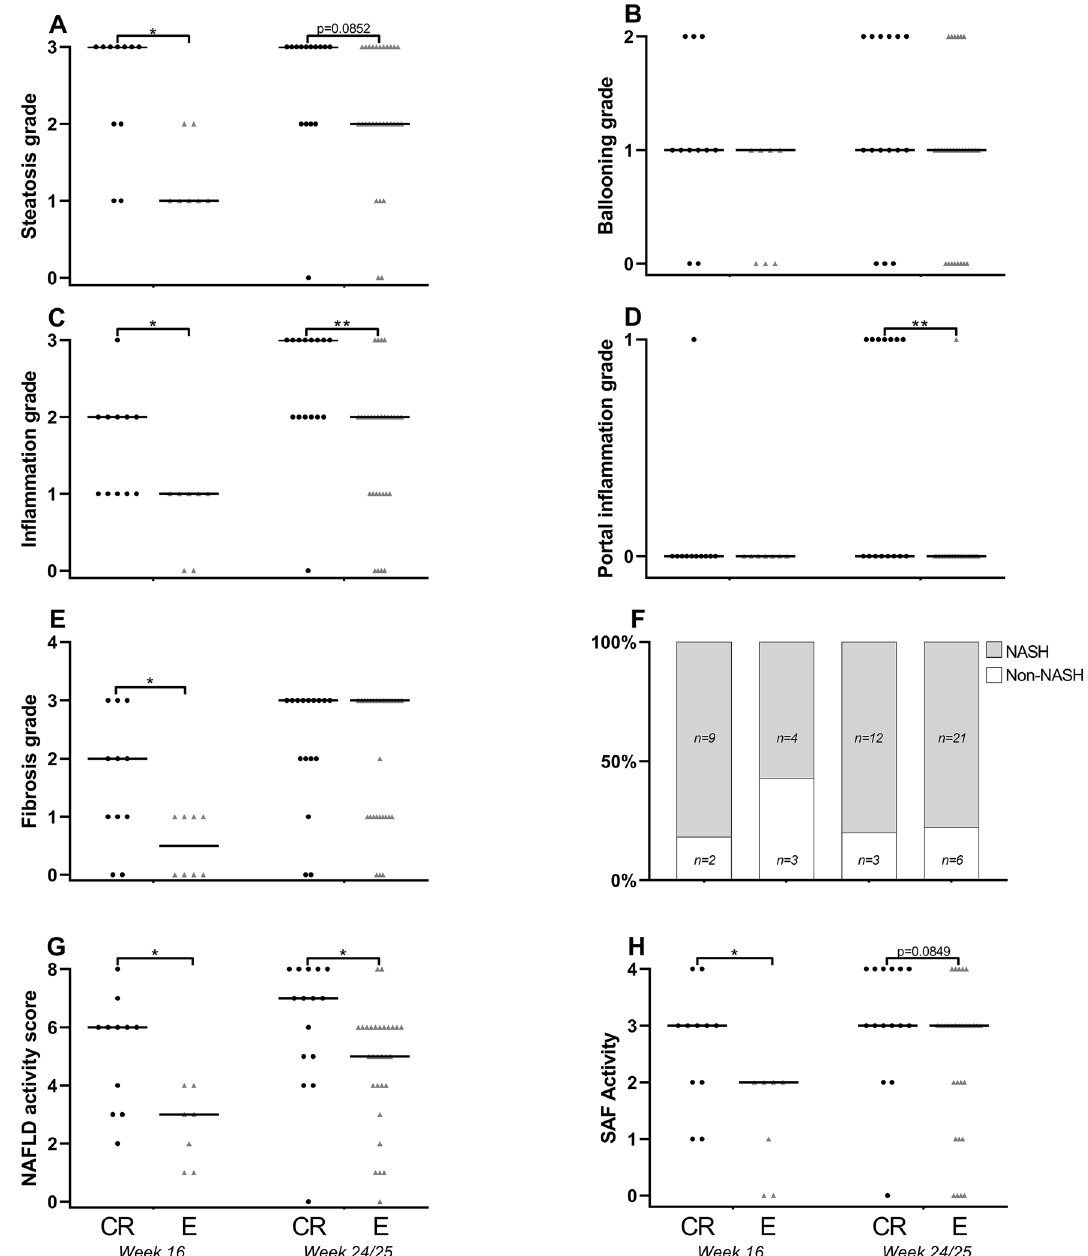
Figure 2. Liver histology and disease severity. Guinea pigs from Charles River displayed an overall more severe NASH phenotype compared with animals from Envigo. ( A ) Steatosis was higher in guinea pigs from Charles River at week 16, ( B ) while hepatocyte ballooning did not differ between animals from the two breeders. ( C ) Lobular inflammation was enhanced at both time-points in animals from Charles River and ( D ) portal inflammation was increased at week 25 compared with Envigo. ( E ) At week 16, fibrosis grade was higher in Charles River, but at week 25 it was similar to Envigo. ( F ) There was no difference between breeders in the amount of animals that developed NASH (defined as the simultaneous presence of steatosis, ballooning and lobular inflammation) at any time-point. ( G , H ) In accordance with the liver histology, animals from Charles River displayed higher disease activity at week 16 and 24/25 when calculated as the NAS and at week 16 when calculated as the SAF activity. Line represents medians. *p < 0.05 **p < 0.01 compared between breeders at the same time-point. Histological scores were analysed at each time-point by Mann–Whitney test ( A – E , G , H ) and frequencies ( F ) by Fishers exact test. CR Charles River ,. E